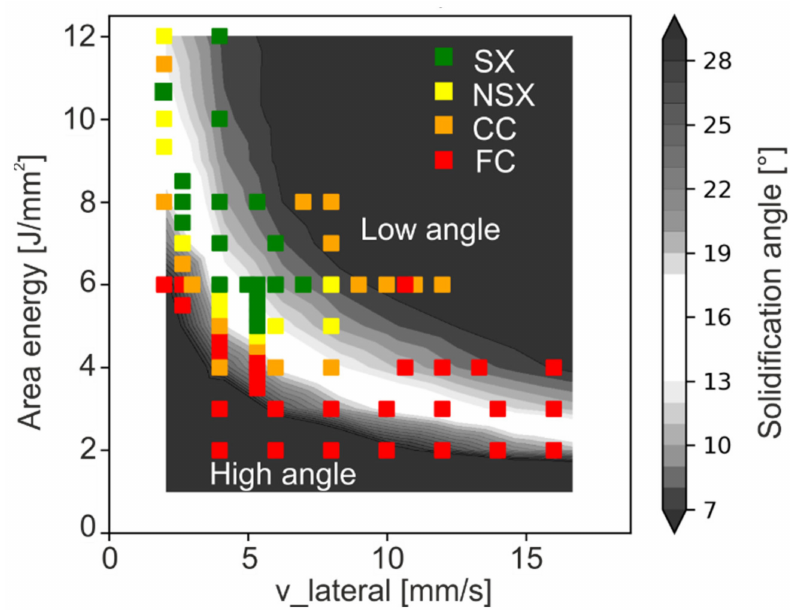
Figure 12. Microstructure map with calculated solidification angle α . Light colors represent regions, where the melt conditions are expected to enable the formation of NSX or SX microstructures according to numerical